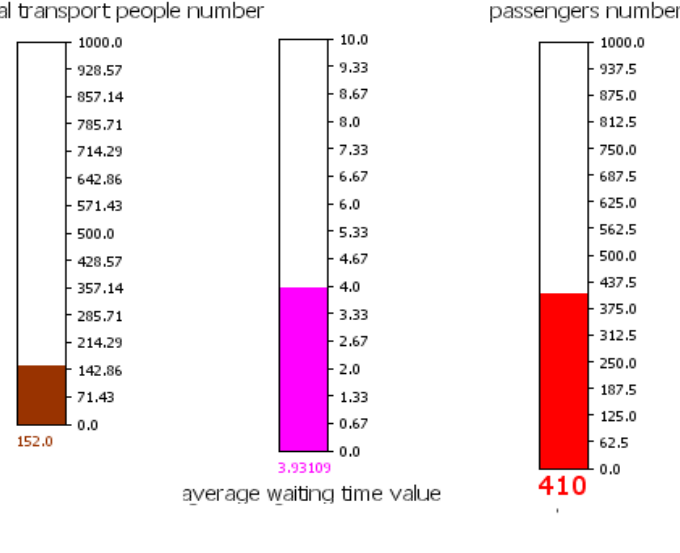
Figure 16. “View of a